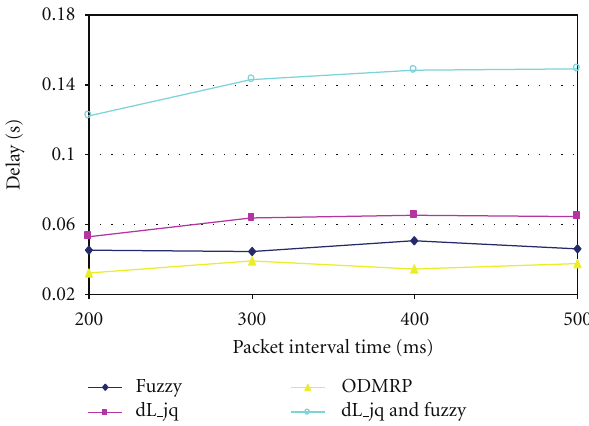
Figure 15: End to end delay with increasing packet interval time.